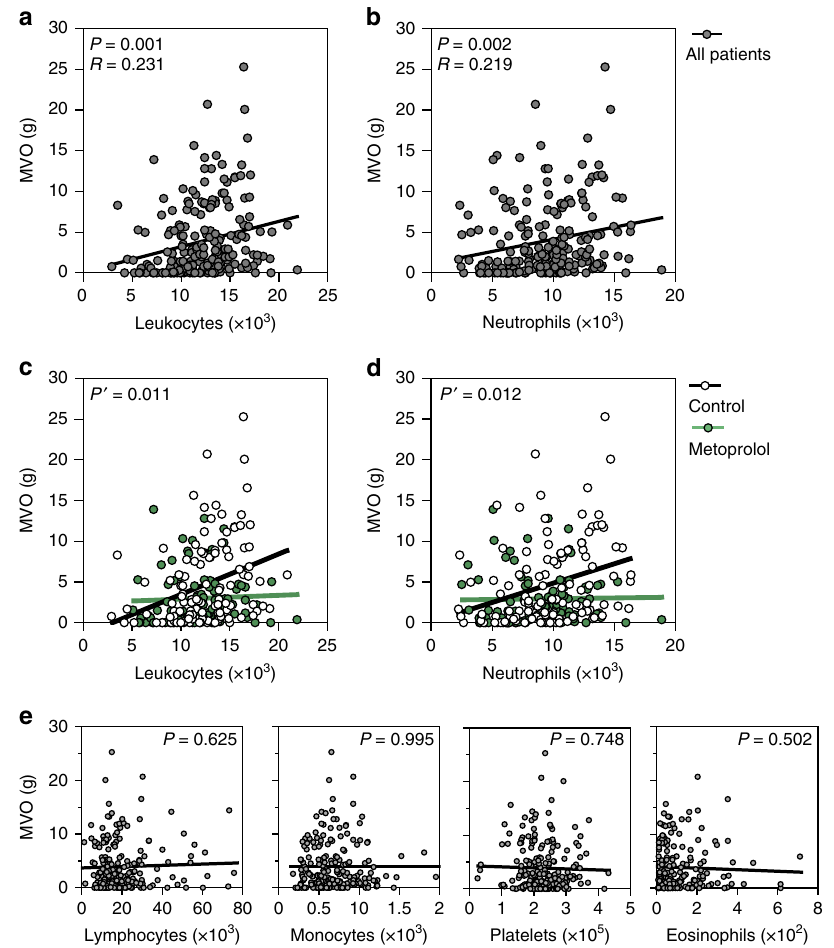
Figure 2 | Metoprolol abrogates neutrophil count positive association with extent of MVO. Sensitivity analysis of the association between MVO and leukocyte and subpopulations count on admission from METOCARD-CNIC trial patients. ( a , b ) Association between MVO and absolute leukocyte or neutrophil count on admission. Grey dots represent individual values and line linear relationship. ( c , d ) Linear regression comparison between MVO and leukocytes and neutrophils in the subsets of METOCARD patients indicating loss of correlation in the metoprolol treated group (green) as compared to control group (white). P 0 , stands for interaction P value. ( e ) Association between MVO and rest of white blood cells subpopulations: Platelets, lymphocytes, eosinophils and monocytes showing no correlation in the extent of MVO. P stands for P value and R , for Pearson’s correlation